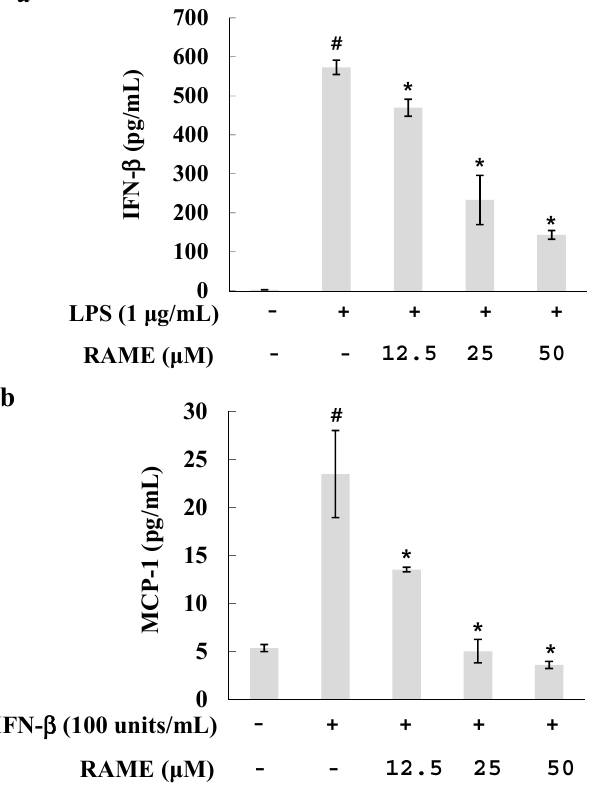
Figure 5. Effects of RAME on the IFN- β pathway. ( a ) RAW 264.7 cells were treated with RAME for 2 h prior to incubation with LPS (1 µ g/mL) for 4 h. IFN- β levels were detected in the culture supernatant using an ELISA kit. # p < 0.05 vs. control group, * p < 0.05 vs. LPS-treated group; ( b ) RAW 264.7 cells were treated with various concentrations of RAME for 2 h prior to incubation with IFN- β (100 units/mL) for 8 h. MCP-1 levels were detected in the culture supernatant using an ELISA kit. # p < 0.05 vs. control group , * p < 0.05 vs. IFN- β -treated group.